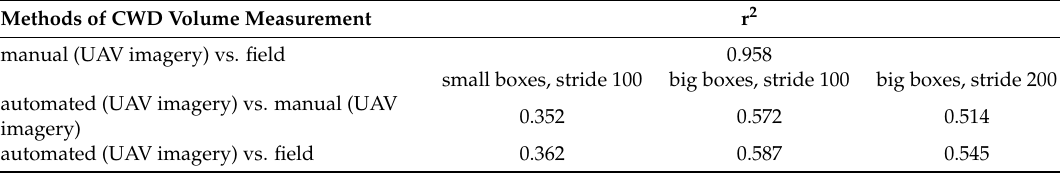
Figure 12. Comparison of plot log volume (excluding stumps) from UAV calculated from automated vs manual, digital-annotations of logs/coarse woody debris. Three different methods for detection are compared: ( a ) Small bounding boxes, detector stride of 100 pixels; ( b ) Large bounding boxes, detector stride of 100 pixels; ( c ) Large bounding boxes, detector stride of 200 pixels. Blue line indicates a linear regression between the data points and red dotted line shows a unit-slope line representing a perfect one-to-one relationship for comparison. The correlation score is shown in the title for each plot. Table 6. A summary for comparing the correlation between different methods of plot CWD volume